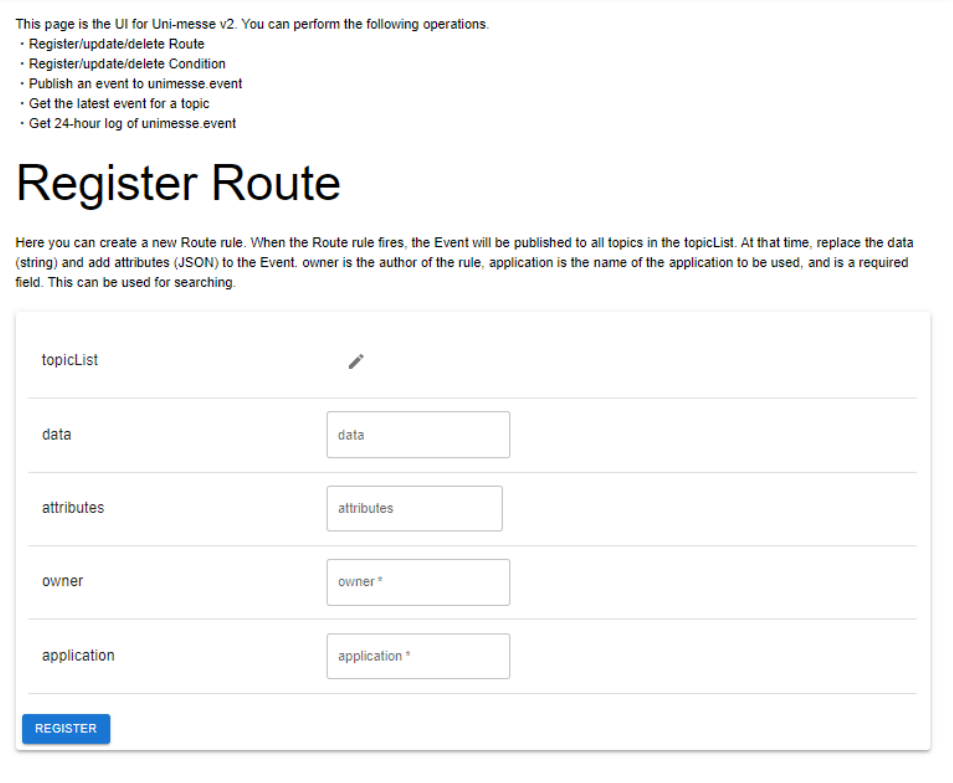
Figure 2. The Web UI of Uni-messe: route registration. Table 2. The operations available in the Web